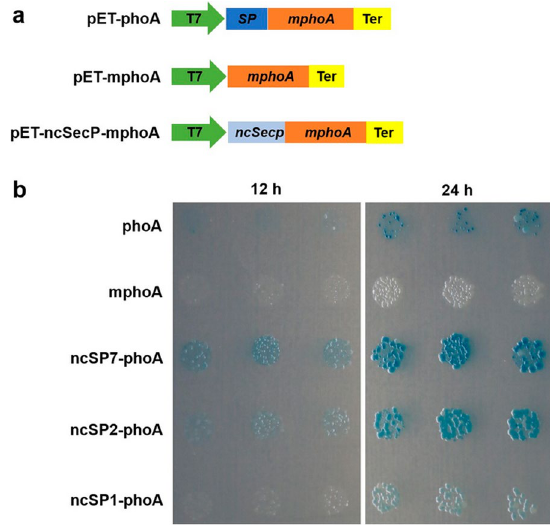
Fig. 2 Validation of the putative ncSecPs of Candidatus Phytoplasma ziziphi by using the Escherichia coli -based PhoA assays. a Diagrams of prokaryotic expression cassettes for phoA and its related fusion genes. The pET-phoA harboring the full-length phoA gene was used as the positive control, while pET-mphoA containing mphoA without a signal peptide (SP)-encoding sequence was used as the negative control. The Ca. P. ziziphin ncSecP was cloned into pET-mphoA and fused with mphoA , resulting in pET-ncSecP-mphoA. T7 indicates T7 promoter, and Ter represents T7 terminator. b PhoA assays verified the secretion of the in silico predicted Ca. P. ziziphin ncSecPs. The E. coli cells expressing phoA fusions were grown on the indicator LB medium, as described in the ‘Methods’ section. The images were taken after 12 and 24 h of incubation. Twenty-five of 37 candidates were clarified to be ncSecPs. Representatives of the ncSecPs with